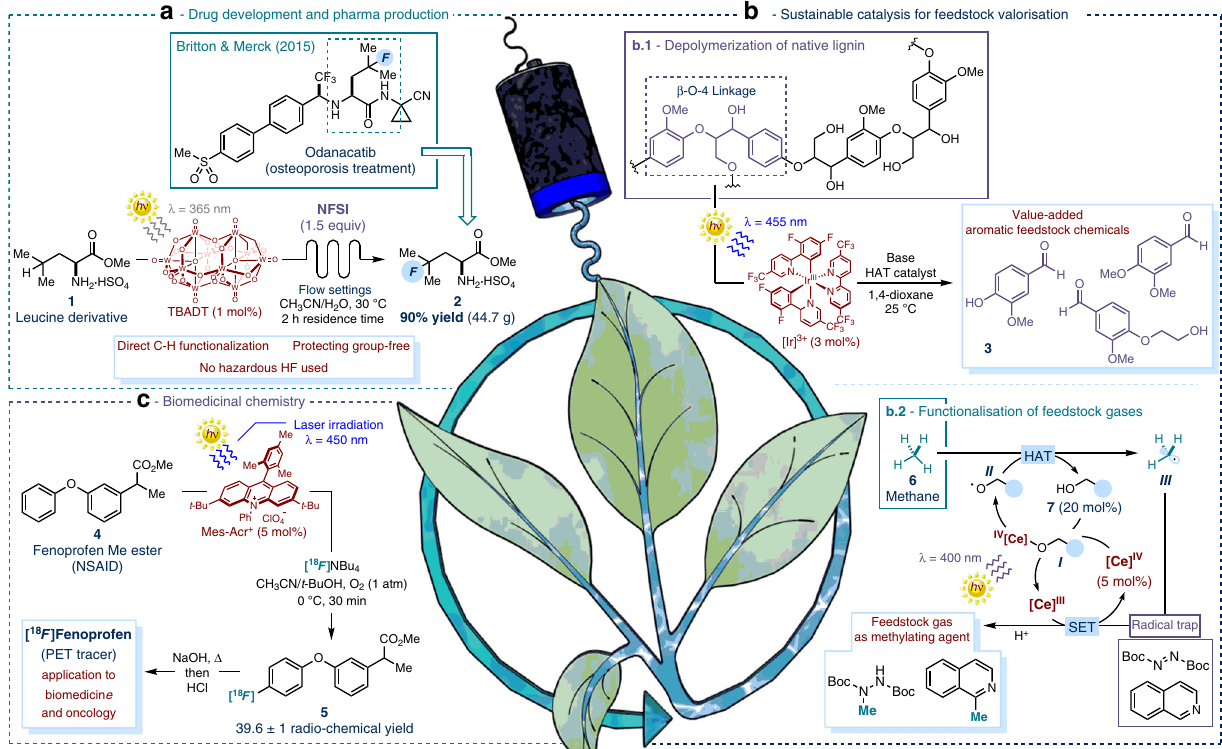
Fig. 1 Sustainable photoredox strategies. a Drug development (synthesis of key drug intermediates), b sustainable catalysis for the valorisation of renewable feedstock (lignin biomass depolymerisation and direct functionalisation of natural gases), c biomedicinal chemistry (provision of radiolabelled tracers). TBADT: tetra-n-butylammonium decatungstenate; NFSI: N- fl uorobenzenesulfonimide; HAT: hydrogen atom transfer; NSAID: nonsteroidal anti-in fl ammatory drug; PET: positron emission tomography; SET: single electron